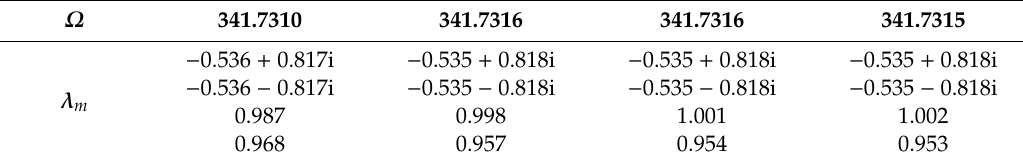
Table 3. Period-2 motion Floquet multipliers λ m around A 4 (counterclockwise, see Figure 3a).